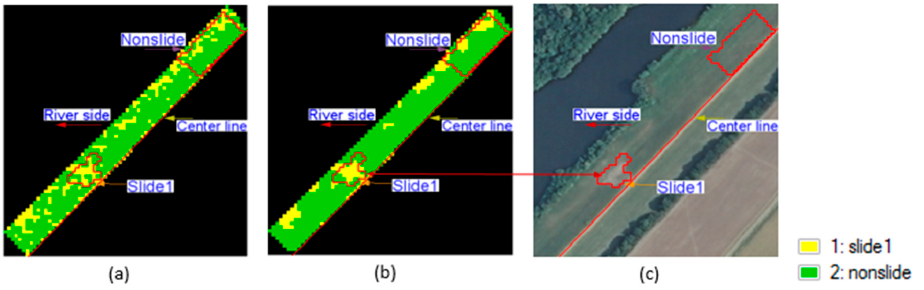
Figure 5. Phase data classification for the segment Sample 1: ( a ) without majority filter; ( b ) with majority filter; ( c ) optical image overlaid with slide and nonslide class shapes. Table 3. Accuracy analysis of the Mahalanobis distance (MD) classification, and with majority filter (MDF) for slide and nonslide areas, of the segment Sample 1, using magnitude, phase, and complex data.